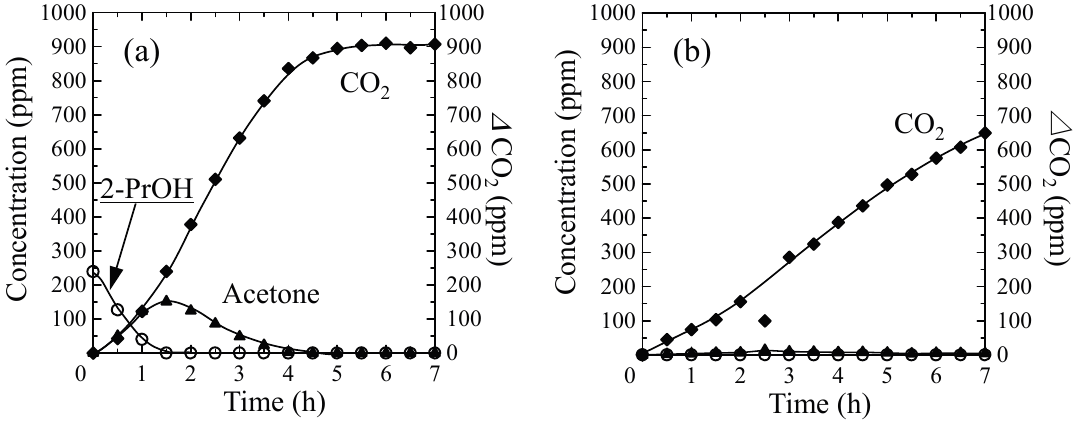
Figure 7. Changes in the concentrations of 2-propanol (open circles), acetone (filled triangles), and Δ CO 2 (filled diamonds, right axis) for the ( a ) TiO 2 -coated partially sintered glass and ( b ) TiO 2 -coated zeolite-porous glass